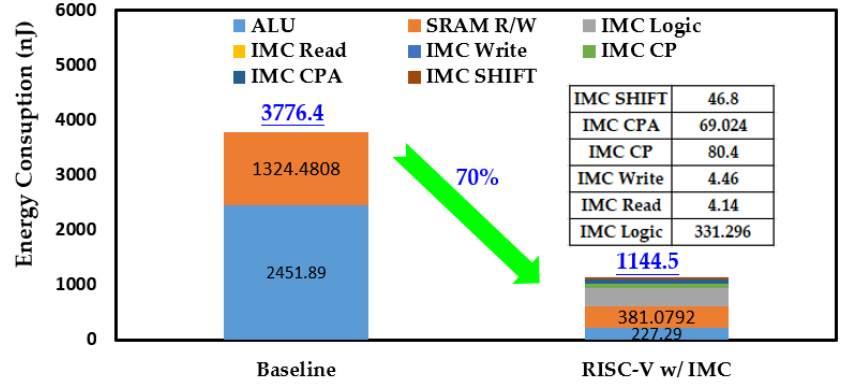
Figure 11. Comparison of instruction count in overall Keccak process.